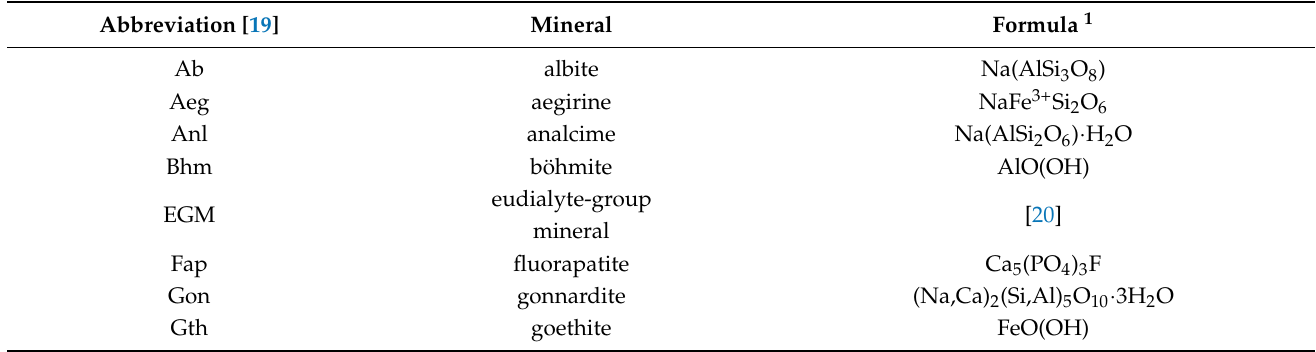
Table 3. Abbreviations, names, and formulas of minerals mentioned in this